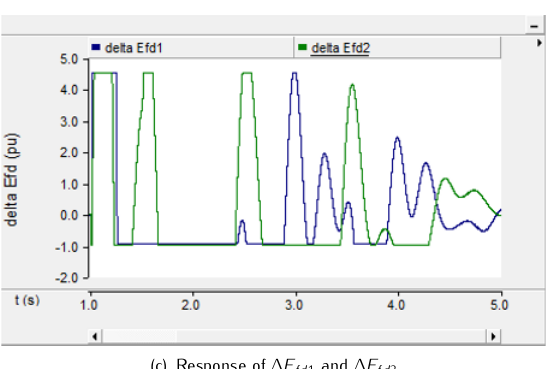
Figure 6 A three-phase fault happened at point f under PSS control Figure 6. A three-phase fault happened at point f under PSS control.